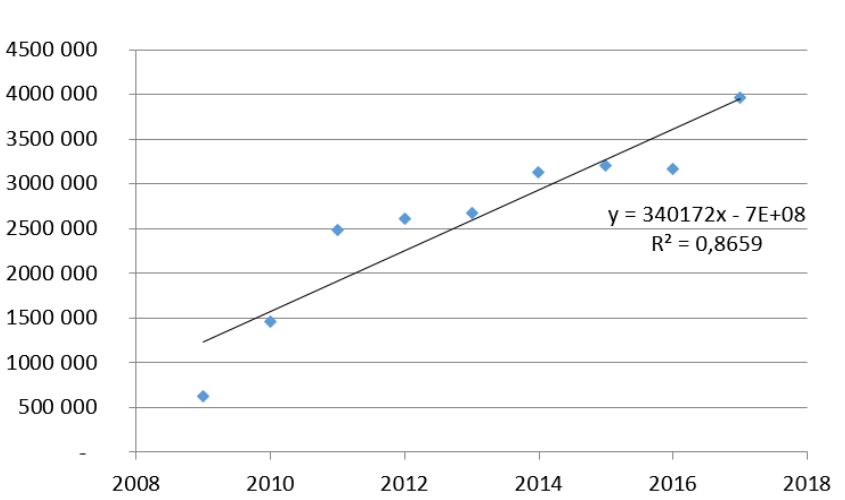
Figure 3. Exports volume of pharmaceutical products from Israel to the EU, 2009-2017 (USD Thousand) The equation of linear regression, constructed according to the data for the period from 2009 to 2017 has a coefficient of determination R 2 = 0,8659, which shows, that, at the average, 86.59% of data variation is determined by the described model. The linear and piecewise linear regression models for the data are presented in the Table 4. Table 4. Regression models describing exports dynamics of pharmaceutical products from Israel to the EU Type of Model Years Formula for the calculation R-squared (R 2 )